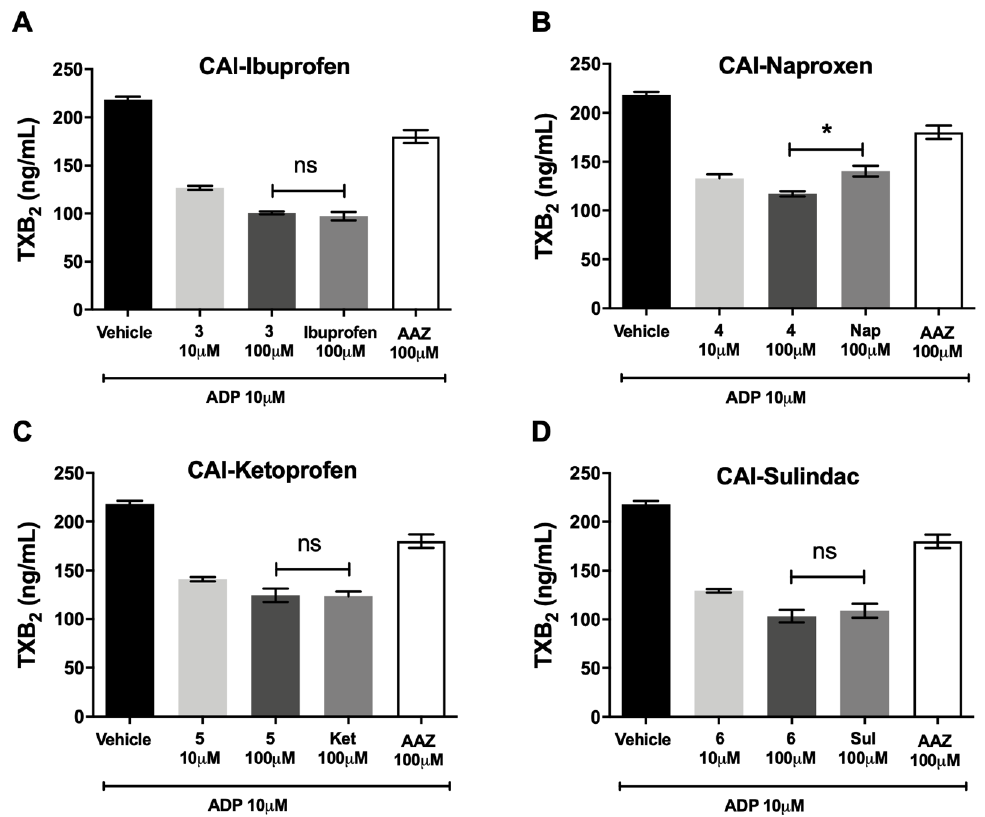
Figure 4. Thromboxane B 2 production. Effects of different concentrations of ( A ) CAI-ibuprofen, ( B ) CAI-naproxen, ( C ) CAI-ketoprofen and ( D ) CAI-sulindac after 5 min of ADP (10 µM) incubation in human PRP. Values represent the mean ± SEM of eight independent experiments (* p < 0.05 between selected columns; ns = non-significant).